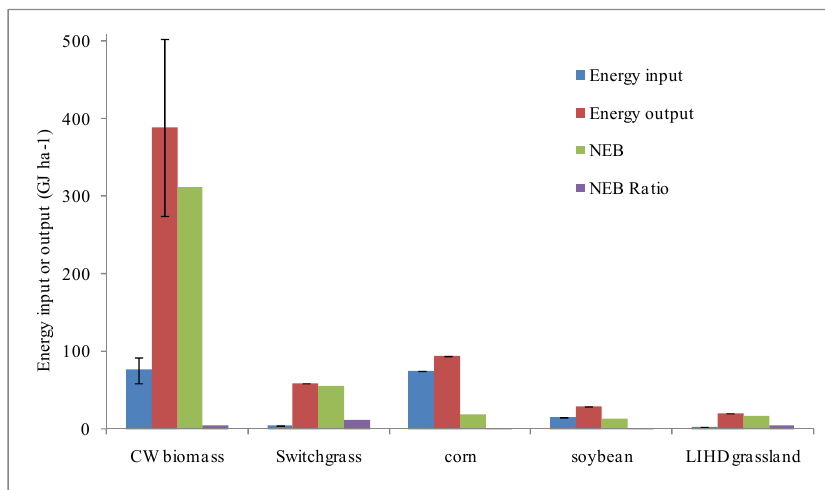
Figure 3. Comparison of energy input, output, NEB (Net Energy Balance), and the NEB ratio for five major biofuels: the CW, switchgrass, corn, soybean, and low-input high-diversity (LIHD) grassland. Note: Energy output for switchgrass, corn, soybean, and LIHD grassland is 60 GJ ha −1 [4], 94.5 GJ ha −1 [5], 29.9 GJ ha −1 [5], and 21.8 GJ ha −1 [5], respectively. NEB = energy output − energy input. The NEB ratio = energy output/energy input.